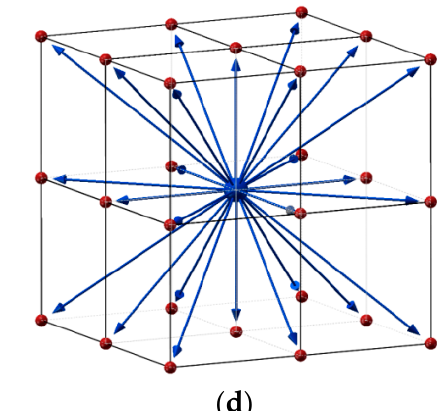
Figure 1. Several typical lattice models: ( a ) D2Q7 model; ( b ) D2Q9 model; ( c ) D3Q19 model; ( d ) D3Q27 model.